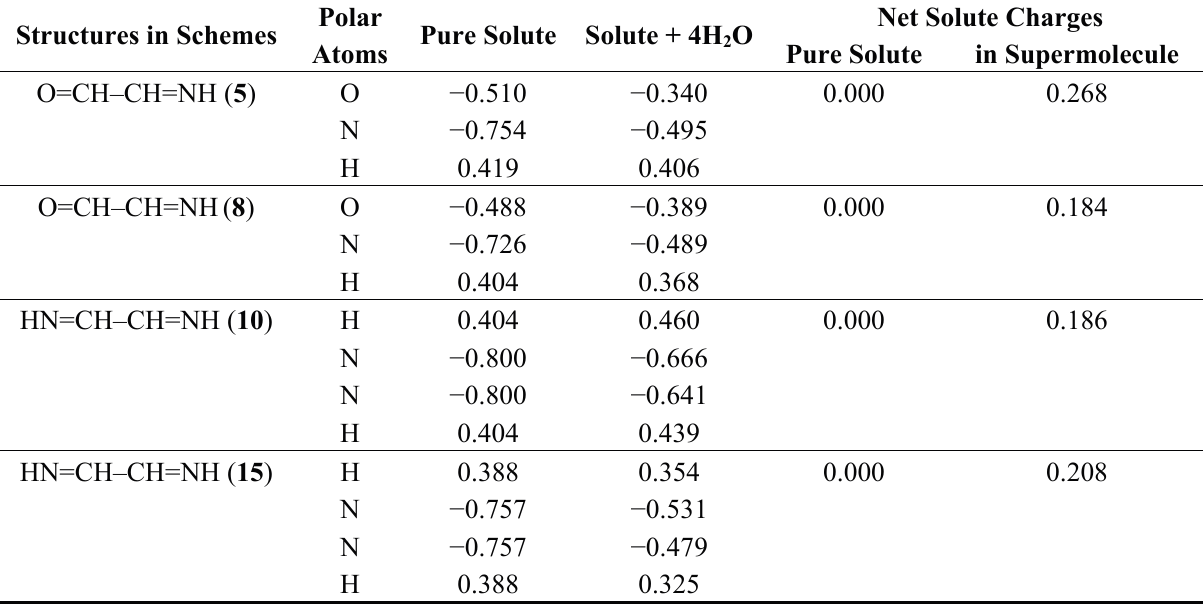
Table 2. B97D/aug-cc-pvtz polar atomic and net solute charges from IEF-PCM calculations a . Structures in